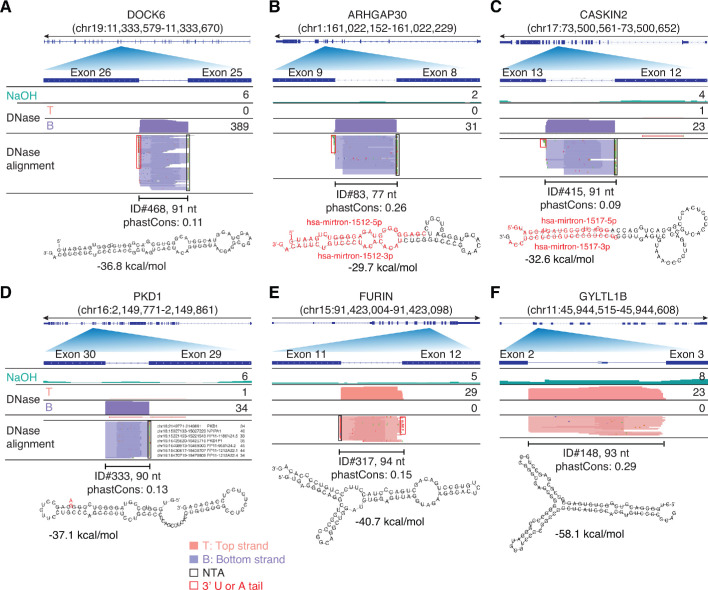
IGV screenshots showing examples of peaks corresponding to putatively structured, full-length excised intron RNAs detected in plasma by TGIRT-seq peak calling.(A–C) Full-length excised intron RNAs that correspond to annotated agotrons or mirtrons. (D–F) Full-length excised intron RNAs that do not correspond to annotated agotrons or mirtrons. Gene names are indicated at the top with the hg19 coordinates of the called peak in parentheses and an arrow below indicating the 5’ to 3’ orientation of the encoded RNA. The top track shows the gene map (exons, thick bars; intron, thin lines), with the relevant part of the gene map expanded below. The tracks below the gene map show coverage plots and read alignments for the peak region in combined datasets for NaOH-treated plasma DNA (n = 4; combined top and bottom strands, turquoise) or DNase-treated plasma RNA (n = 15; Top strand (T), pink and Bottom strand (B), purple) based on the number of deduplicated reads indicated at the right in the coverage tracks. Colors other than pink or purple in the read alignments indicate bases that do not match the reference sequence (red, green, blue, and brown indicate thymidine, adenosine, cytidine, and guanosine, respectively). The peak called by MACS2 is delineated by a bracketed line with the peak ID, length, and phastCons score for 46 vertebrates including humans indicated below (see phylogenetic tree in Figure 10). The most stable predicted secondary structure and its MFE (ΔG) computed by RNAfold are shown below the peak ID. The annotated mature miRNA and passenger strands of mirtrons are highlighted in red within the predicted secondary structure. Red boxes, short (1–2 nt) non-templated 3' U or A tails; NTA/black boxes are non-templated nucleotides added by TGIRT-III to the 3' end of cDNAs (5' end of the RNA sequence) during TGIRT-seq library preparation.